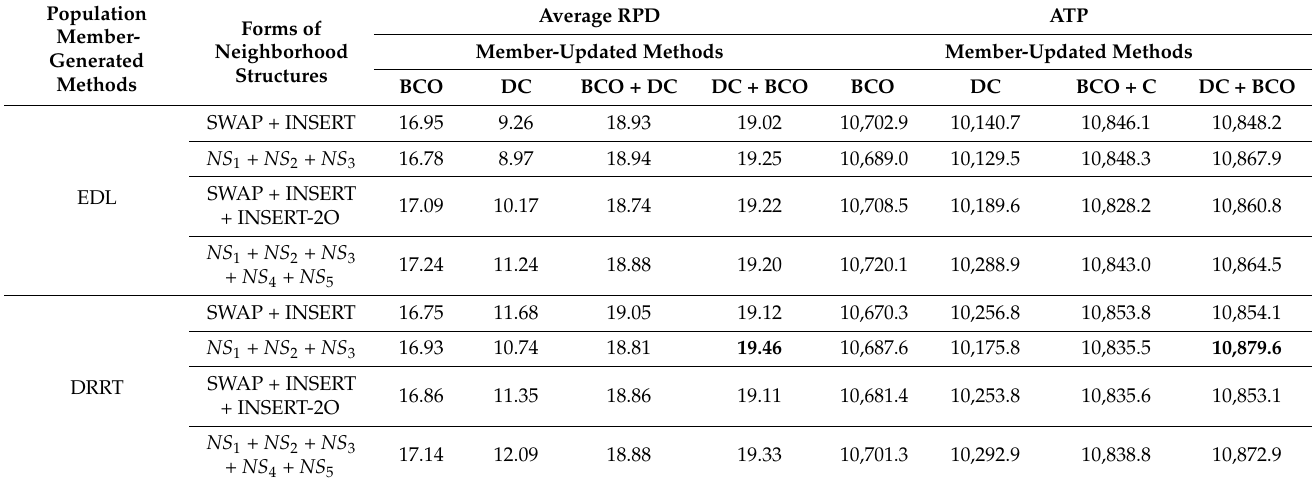
Table 1. Performance comparisons of the parameters in IPBM (in terms of average RPD and